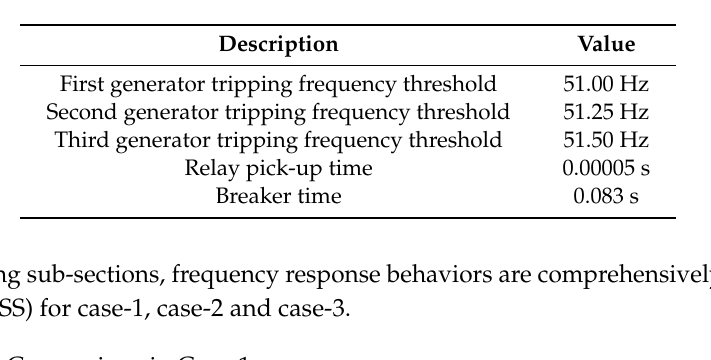
Table 4. Overview of OFGS